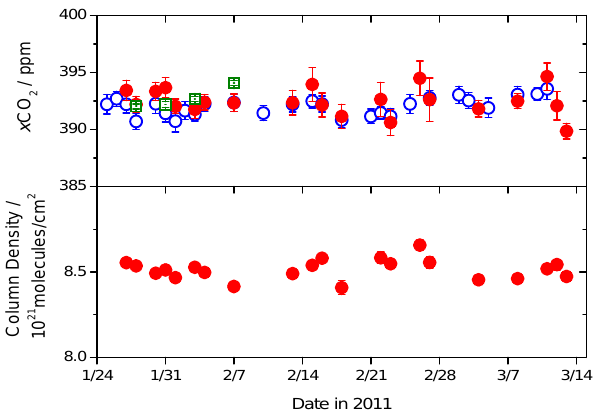
Fig. 7. Vertical profiles of temperature and CO 2 concentration over Tsukuba in Japan on 28 (black), 31 January (red), 3 (blue) and 7 February 2011 (olive). Details are given in the text.